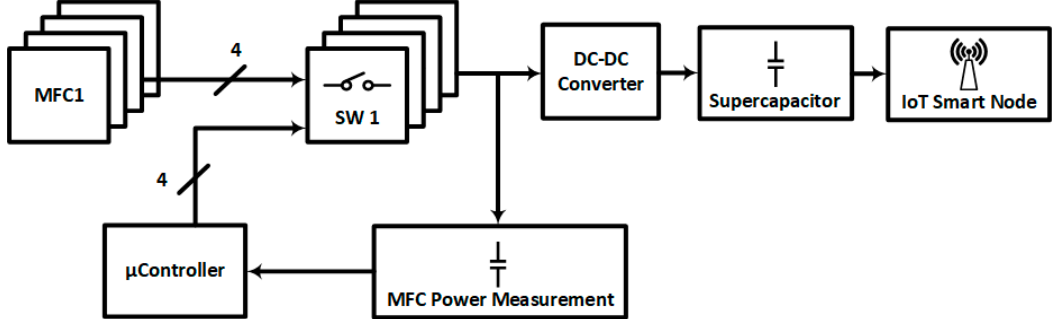
Figure 3. Block diagram of the proposed Power Management System (PMS).